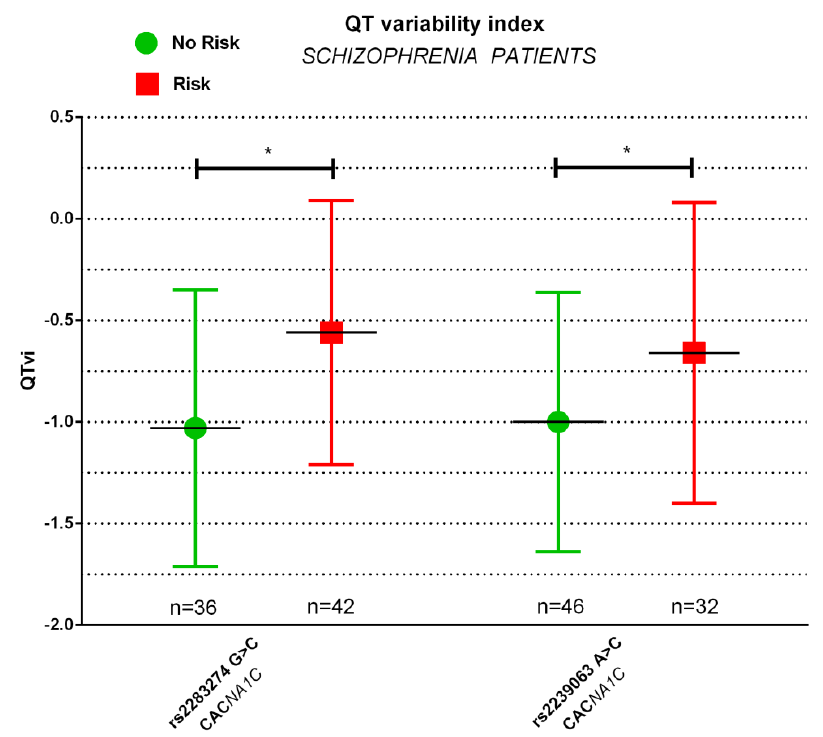
Figure 1. Error bar chart illustrating differences in QTvi (bpm) between genotype risk in CACNA1C rs2283274 (GG vs. CG/CC) and rs2239063 (AA vs. AC/CC) in unmedicated patients with schizophre- nia, * p < 0.05, p -value resulting from ANOVAs.